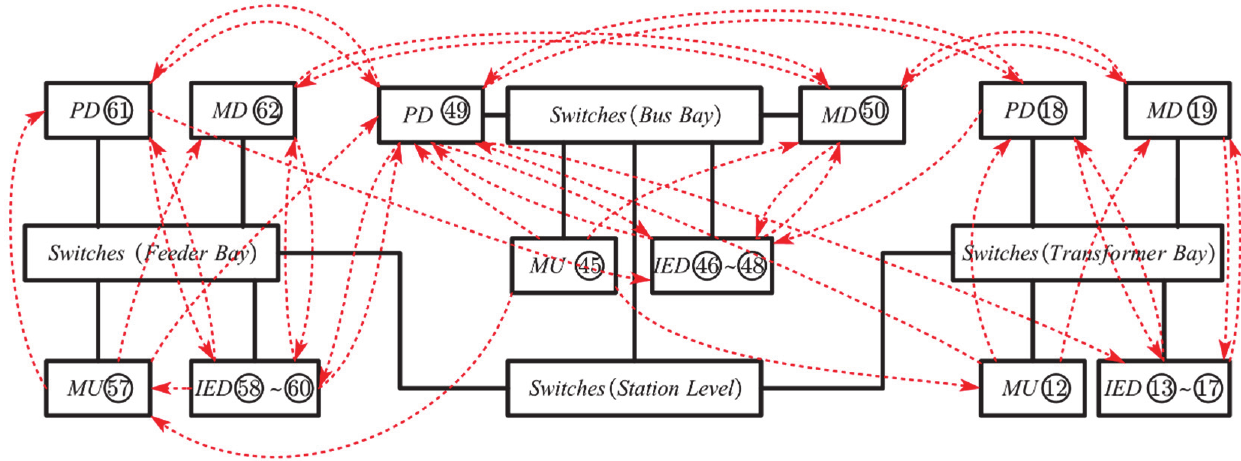
Figure 3. The message flow of smart substation.